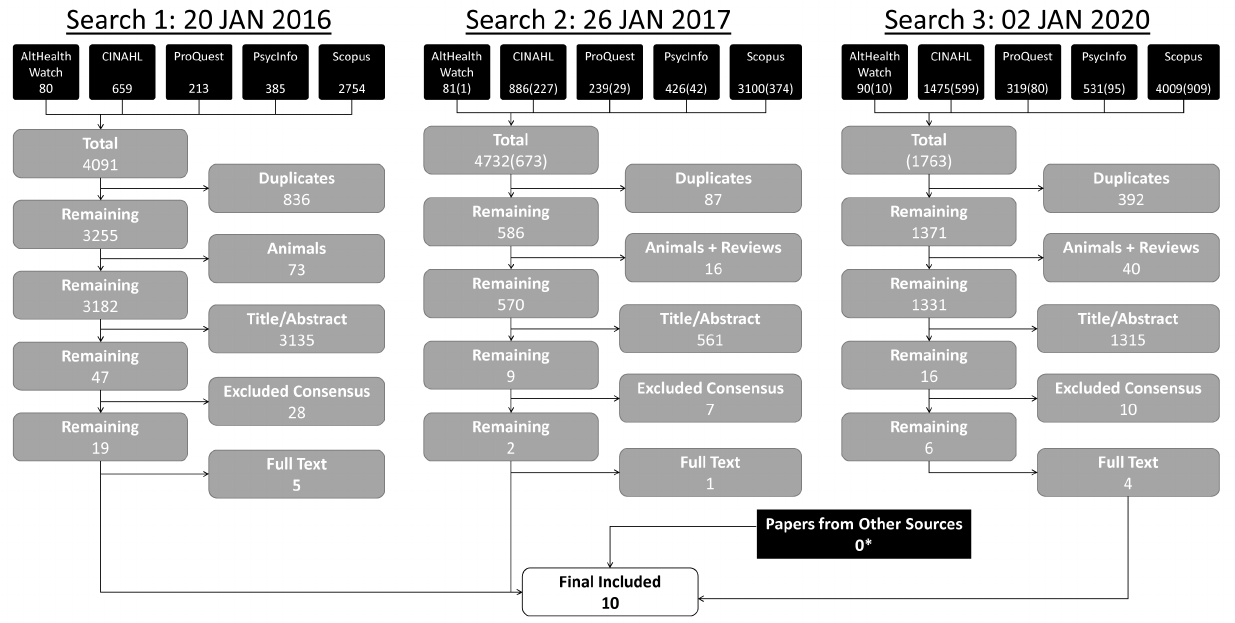
Figure 1. PRISMA diagram. Three searches were undertaken. For searches 2 and 3, the numbers in parentheses represent unique results to that search. *Several ‘papers from other sources’ were identified in prior searches, but those papers were captured by the third search.